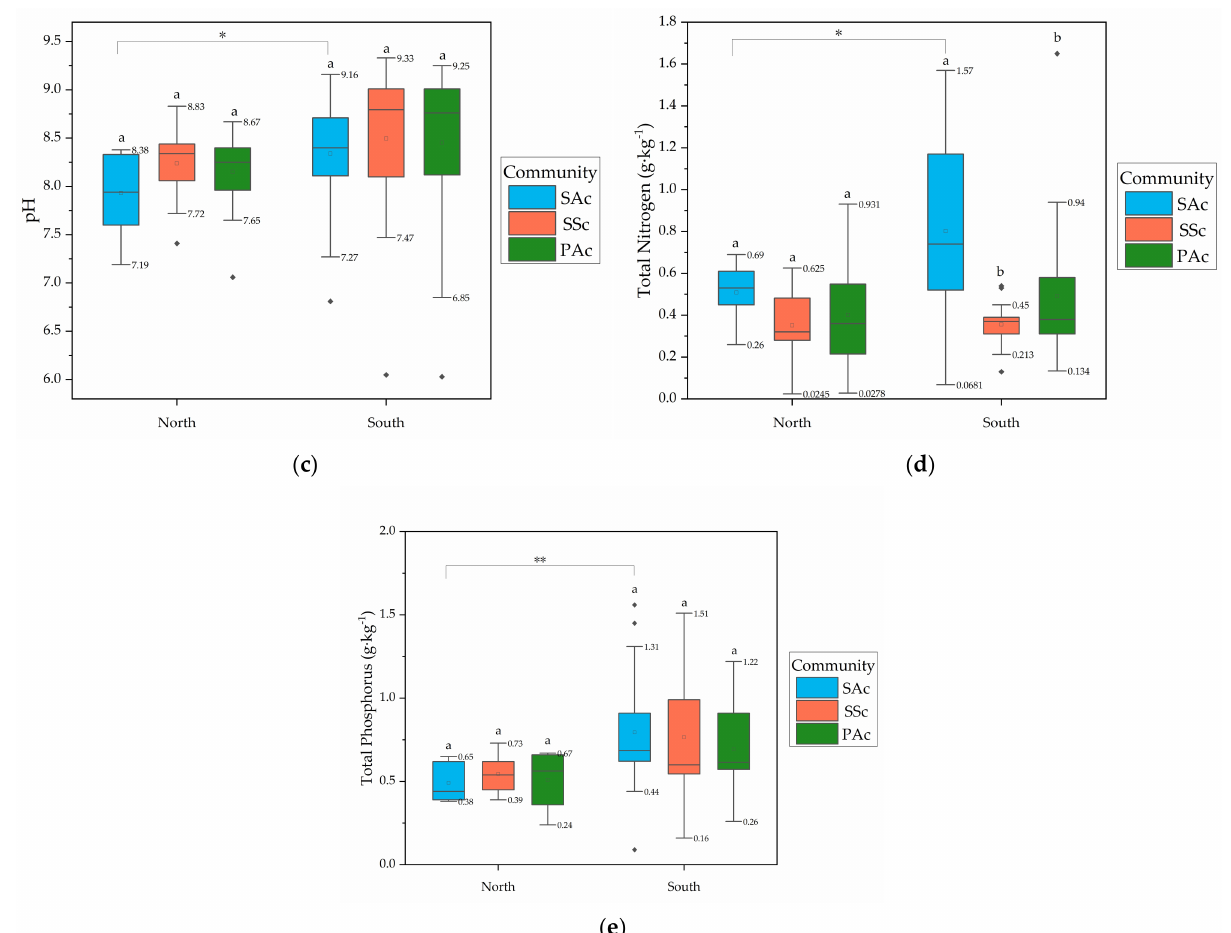
Figure 2. Box plots of the differences in soil factors corresponding to the three communities by region: ( a ) bulk density; ( b ) salinity; ( c ) pH; ( d ) TN; and ( e ) TP. Different colors represent different communities. Boxes show the 25th and 75th percentiles and medians (thick lines), while staples indicate the smallest and highest values (excluding outliers). Outliers are shown as solid circles. The range of whiskers is marked in the figure. Lowercase letters indicate the significance of differences between communities within a group, where “a, b” indicates significant difference among the three communities ( p < 0.05). Differences between groups are marked with an asterisk in the figure, and are not marked if the difference is not significant, where ‘**’ represents p < 0.01, ‘*’ represents p <